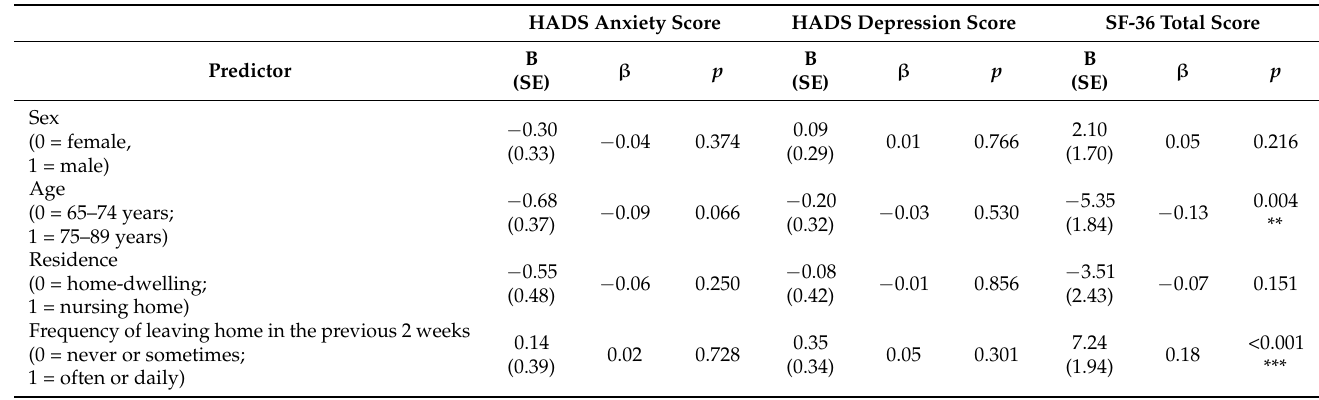
Figure 1. Correlation matrix of the study measures (SF-36, UCLA, FACIT-Sp, HADS Anxiety, and HADS Depression). Asterisks denote a significant correlation, *** p < 0.001. Table 4. Multiple linear regression models of anxiety symptoms (HADS Anxiety score), depression symptoms (HADS Depression score), and health-related quality of life (SF-36 score); * p < 0.05, ** p < 0.01, and *** p <